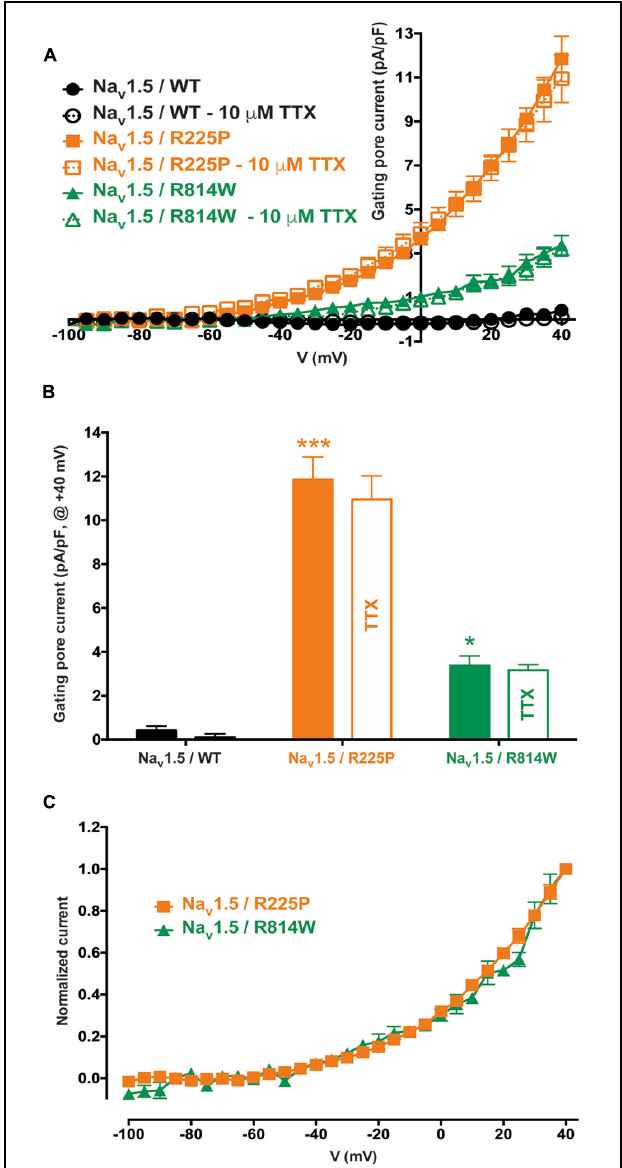
FIGURE 4 | Voltage dependence of gating pore currents. (A) Current density-voltage relationships of gating pore currents recorded for the WT, R225P, and R814W channels are shown as filled symbols in the absence of TTX ( n = 5 for R225P, n = 4 for R814W, and n = 4 for WT channels) and as empty symbols in the presence of 10 μ M TTX ( n = 6 for R225P, n = 3 for R814W, and n = 5 for WT channels). (B) Histograms summarizing the gating pore current densities at + 40 mV for the WT, R225P, and R814W channels (0.4 ± 0.2 pA/pF, 11.8 ± 1.0 pA/pF, and 3.4 ± 0.4 pA/pF, respectively). No differences were observed with or without TTX for any of the conditions. (C) Normalized gating pore currents (I/I max ) exhibiting similar voltage dependence for both the R225P and R814W mutant channels. ∗ Difference vs. Na v 1.5/WT ( ∗∗∗ P <